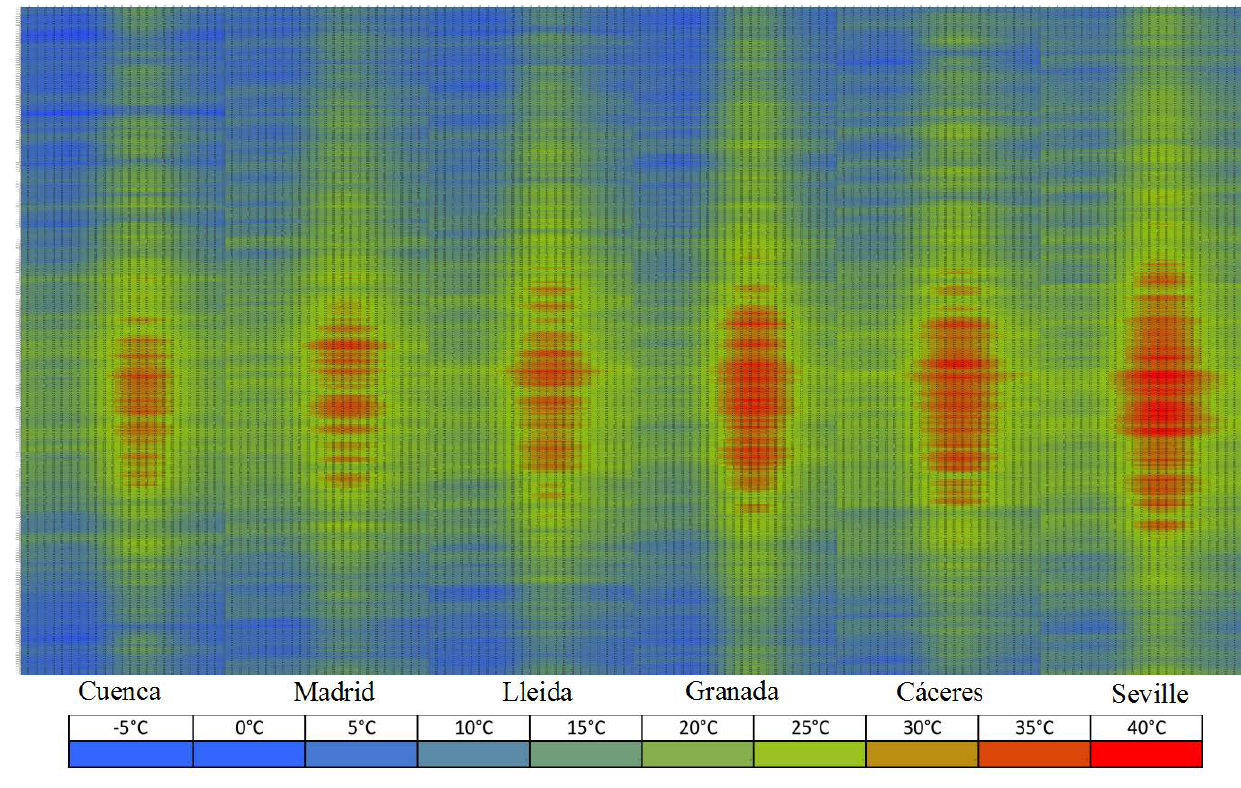
Figure 14. Hourly temperatures in the cities studied over a one-year